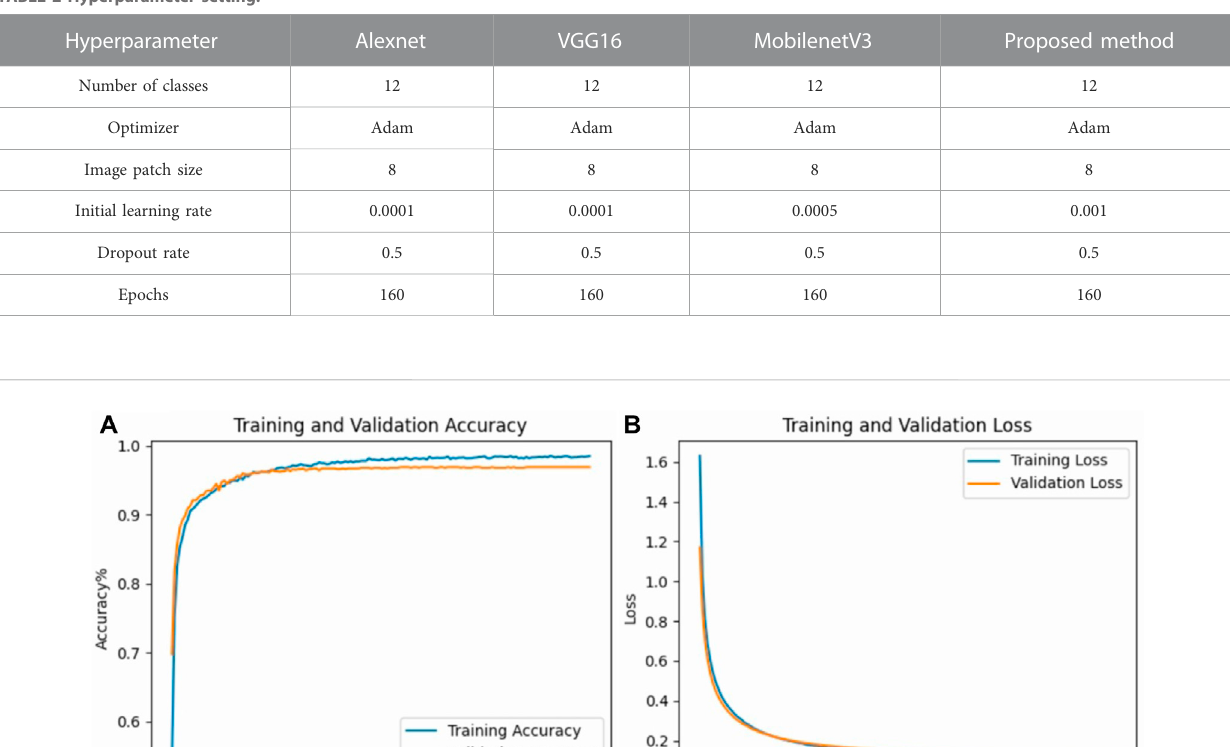
TABLE 2 Hyperparameter setting.